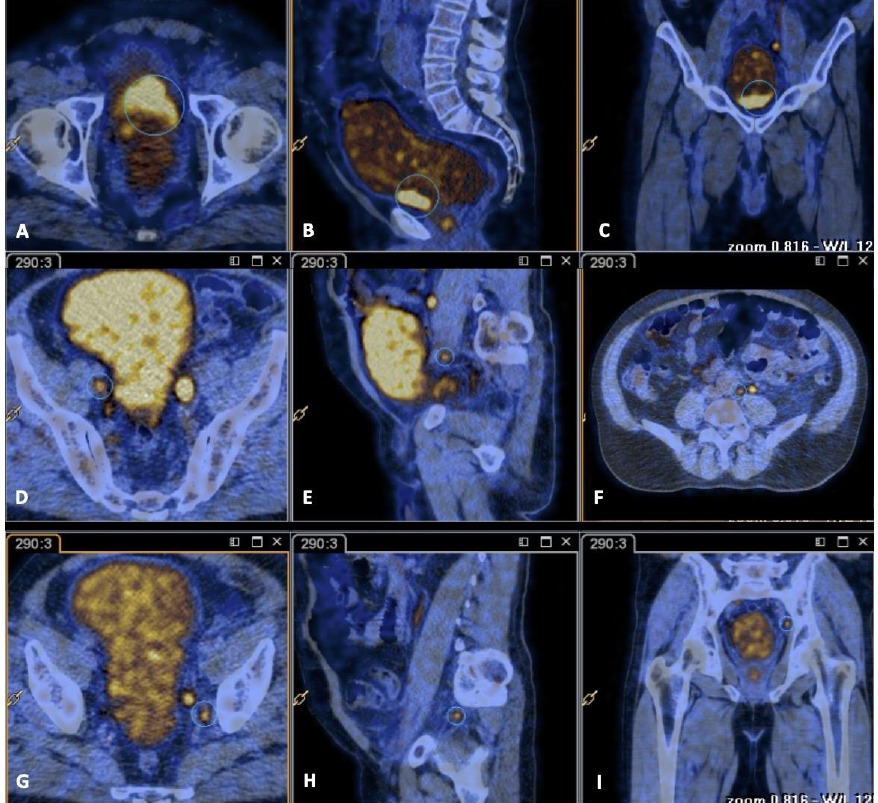
Figure 2. FDG-PET/CT showing significant metabolic activity in bilateral pelvic lymph nodes and mild metabolic activity in the femoral and retroperitoneal LN. ( A ) Transverse low-pelvic slice showing significant metabolic activity in the anterior aspect of the bladder (circled in green). ( B ) Sagittal pelvic slice showing significant metabolic activity in the anterior aspect of the bladder (circled in green). ( C ) Coronal anterior pelvic slice showing significant metabolic activity in the anterior aspect of the bladder (circled in green). ( D ) Transverse high-pelvic slice showing significant metabolic activity in the right pelvic lymph nodes (circled in green). ( E ) Right parasagittal slice showing significant metabolic activity in the right pelvic lymph nodes (circled in green). ( F ) Mid-abdominal slice showing mild metabolic activity in retroperitoneal lymph nodes (circled in green). ( G ) Transverse mid-pelvic slice showing significant metabolic activity in the left pelvic lymph nodes (circled in green). ( H ) Left parasagittal slice showing significant metabolic activity in the left pelvic lymph nodes (circled in green). ( I ) Coronal posterior pelvic slice showing significant metabolic activity in the left pelvic lymph nodes (circled in green).